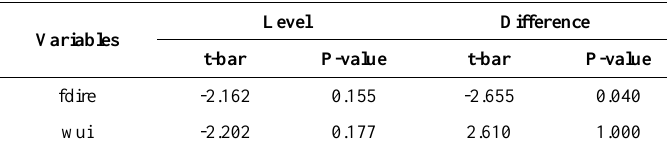
Figure 3. Foreign Direct Real Estate Investments in Selected EU Countries (2008–2018) (Million $) [40]. Table 1. Im-Pesaran-Shin Unit Root Test.